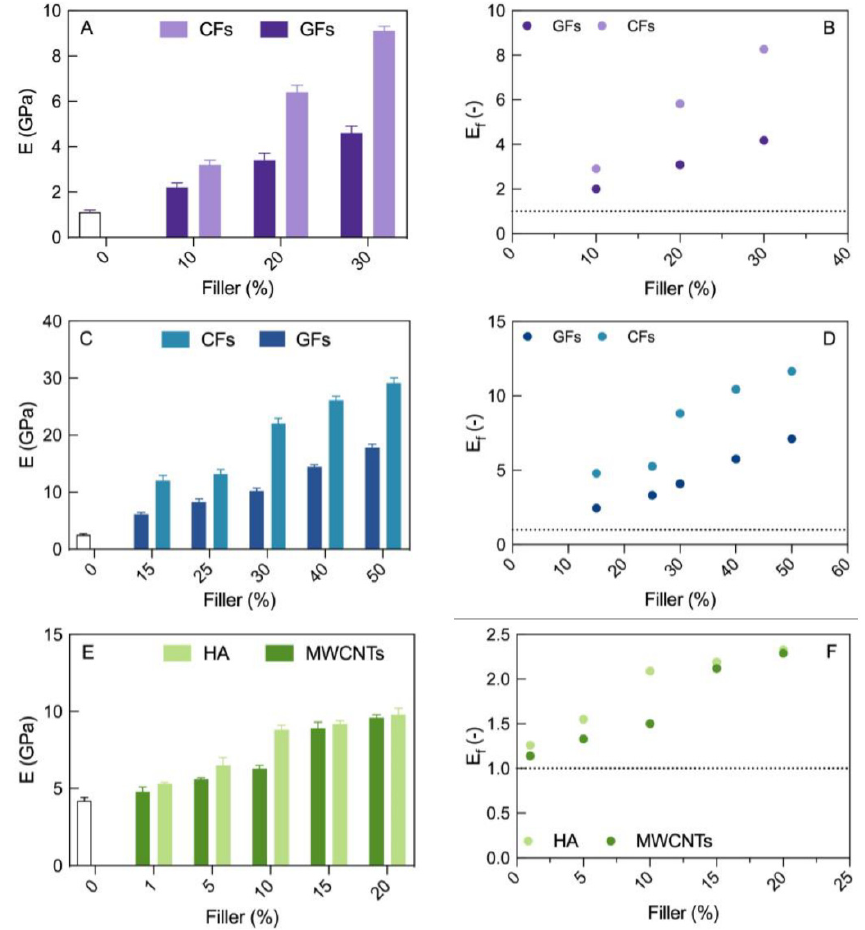
Figure 1. CAMMD-based predicted values of the Young modulus E ( A , C , E ) and the corresponding enhancement factor E f (=E of the (nano)composite/E of the pristine polymeric matrix) ( B , D , F ) for the different polymer/filler systems as a function of fibre loading (% wt). ( A , B ): PA6 loaded with GFs or CFs; ( C , D ): PA6,6 loaded with GFs or CFs; ( E , F ): PEEK loaded with MWCNTs or HA.